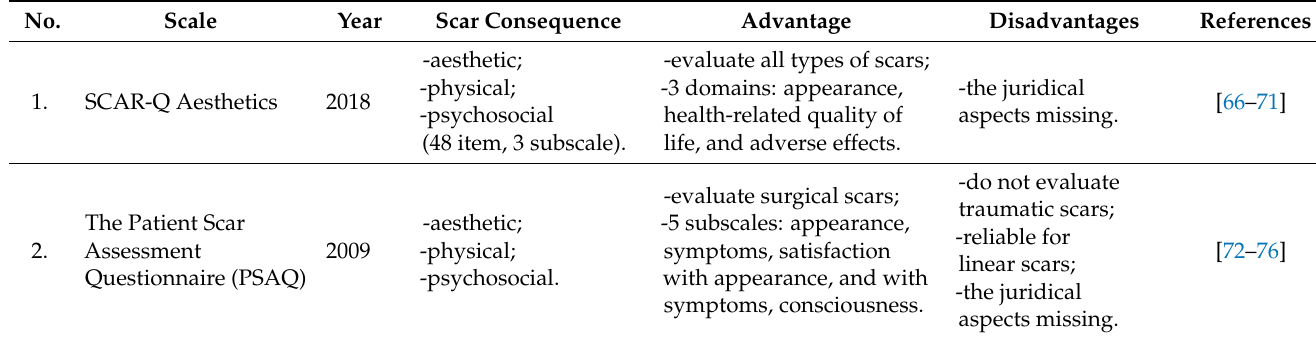
Table 3. Scales for Physical and Psychosocial Assessment of